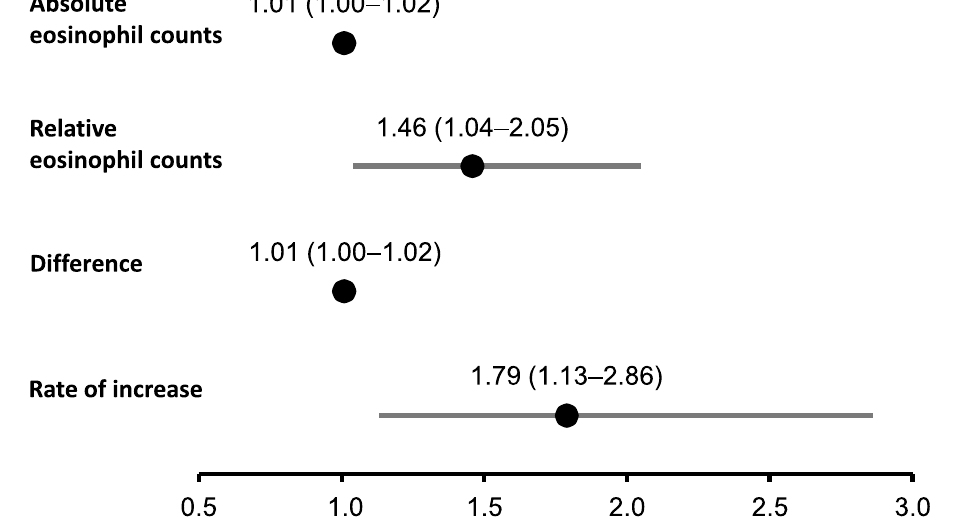
Figure 2. Eosinophil counts as predictors of AI determined by logistic regression analysis. Odds ratios (ORs) with 95% confidence intervals (CIs) are shown. Adjusted for multiple factors: serum sodium, C-reactive protein, and plasma glucose. Difference: difference in absolute eosinophil counts between the baseline and at pre-onset. Rate of increase: rate of increase in eosinophil counts between the baseline and at